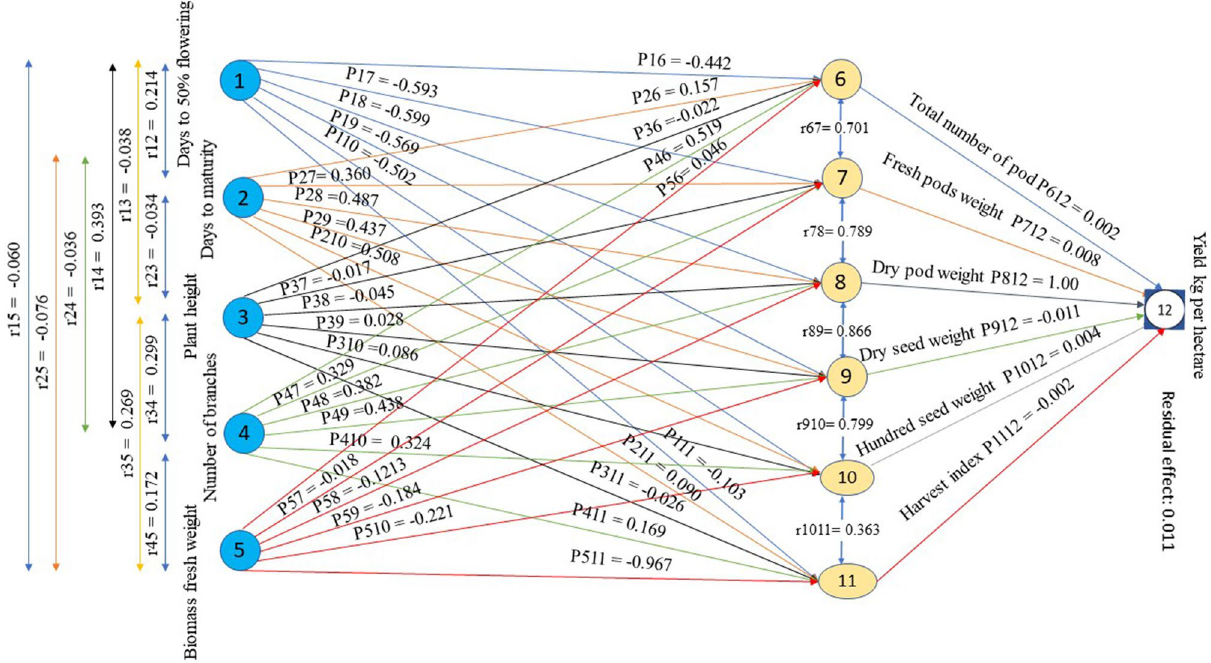
Figure 1. G e notypic path coefficient diagram representing cause and effect relationships among quantitative traits and grain yield. Path diagram and coefficients of factors on the influence of first order on the second-order components and the latter on yield kg per hectare of V. subterranea genotypes . Here, P ij is the direct effects and r ij are the correlation coefficients. The single arrowed lines in the path diagram reflect direct effect, whereas the double arrowed lines reflect mutual connection. Note : 1 = Days to 50% flowering (D50%F); 2 = Days to maturity (DTM); 3 = Plant height (PH); 4 = Number of branches per plant (NB); 5 = Biomass fresh weight (BFW); 6 = Total number of pods per plant (TNP); 7 = Fresh pod weight per plant (FPW); 8 = Dry pod weight per plant (DPW); 9 = Dry seed weight per plant (DSW); 10 = Hundred seed weight (HSW); 11 = Harvest index (HI); 12 = Yield kg/ hectare